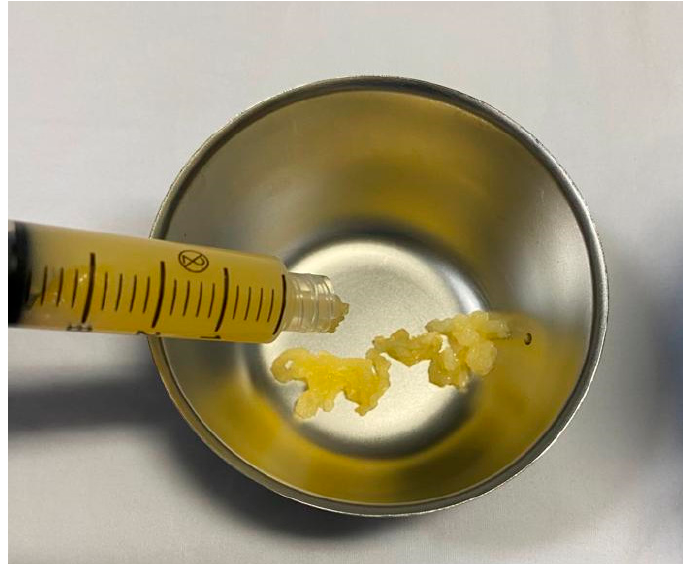
Figure 2. Heat-induced plasma gel formation.